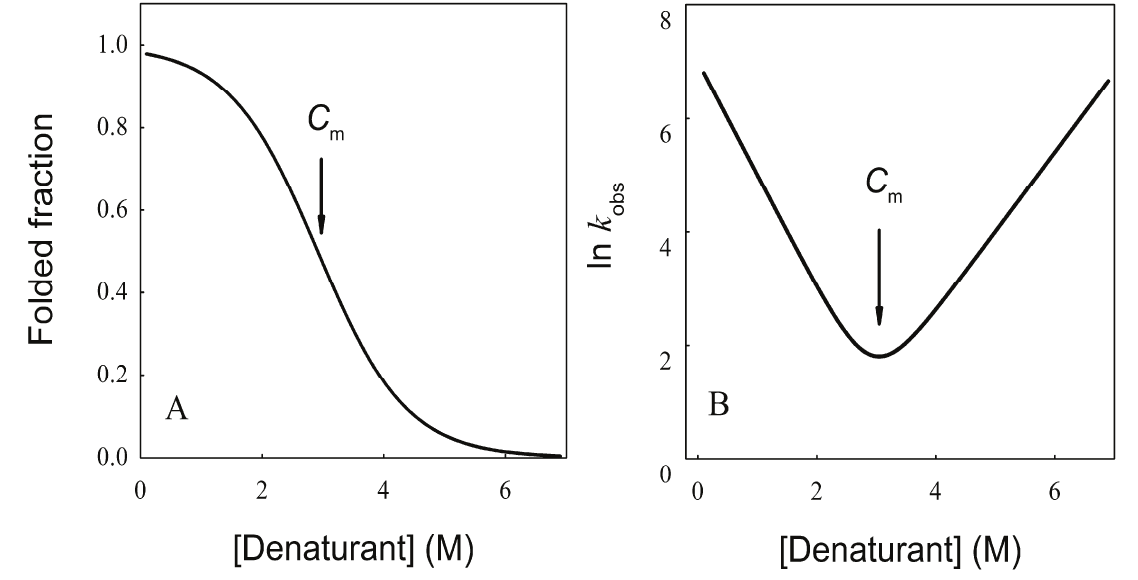
Figure 3. Equilibrium unfolding curve and Chevron Plot for two-state protein unfolding. ( A ) Representation of the equilibrium folded fraction of a protein as a function of denaturant concentration. It can be observed that either at low or high denaturant concentrations, the folding equilibrium is minimally modified by the addition of denaturant. Conversely, at intermediate denaturant concentrations the equilibrium is significantly shifted, leading to a broader change in folded and unfolded concentrations. The maximal slope is related to the cooperativity of the process ( m value). The concentration where 50% of the population is folded and 50% unfolded is called the mid-denaturant concentration ( C ); ( B ) The natural m logarithm of the observed kinetic coefficient is plotted as a function of denaturant concentration ( Chevron Plot ). The folding arm is usually explored in refolding experiments where the unfolded protein in the presence of high denaturant concentration is diluted with buffer without denaturant, and the unfolding arm is mainly obtained from kinetic unfolding experiments. This is because determining kinetic coefficients requires a significant change in the signal used to monitor the unfolding/refolding